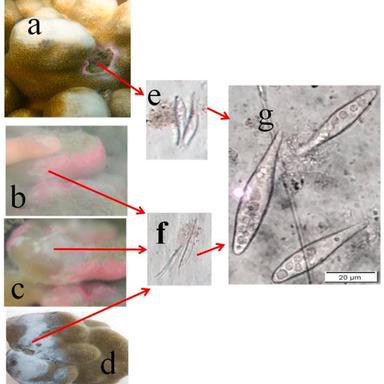
Porites lutea disease lesions and the associated ciliate. a. tissue with discoloration of pink colour surrounding the dead tissue. b and c. the tissue with inflammation due to stress and formation of white layer. d. The tissue with advanced stage with white mate. e, f and g the ciliate isolated from the Porites lutea disease lesions.